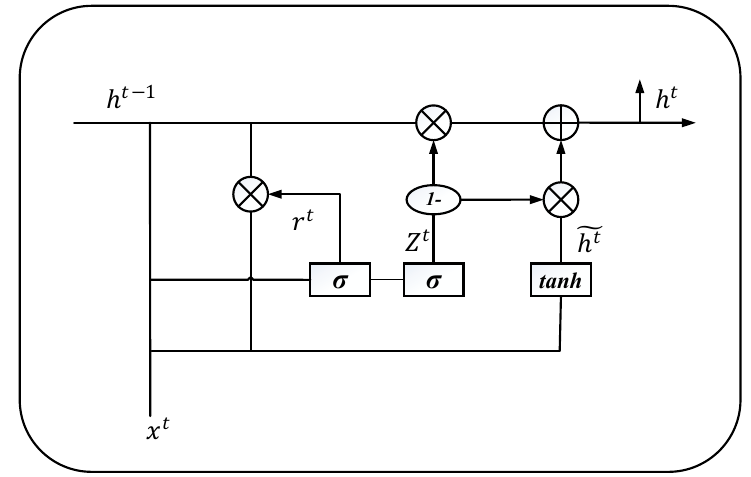
Figure 3. The structure of the Gated Recurrent Neural Networks (GRU) Model.